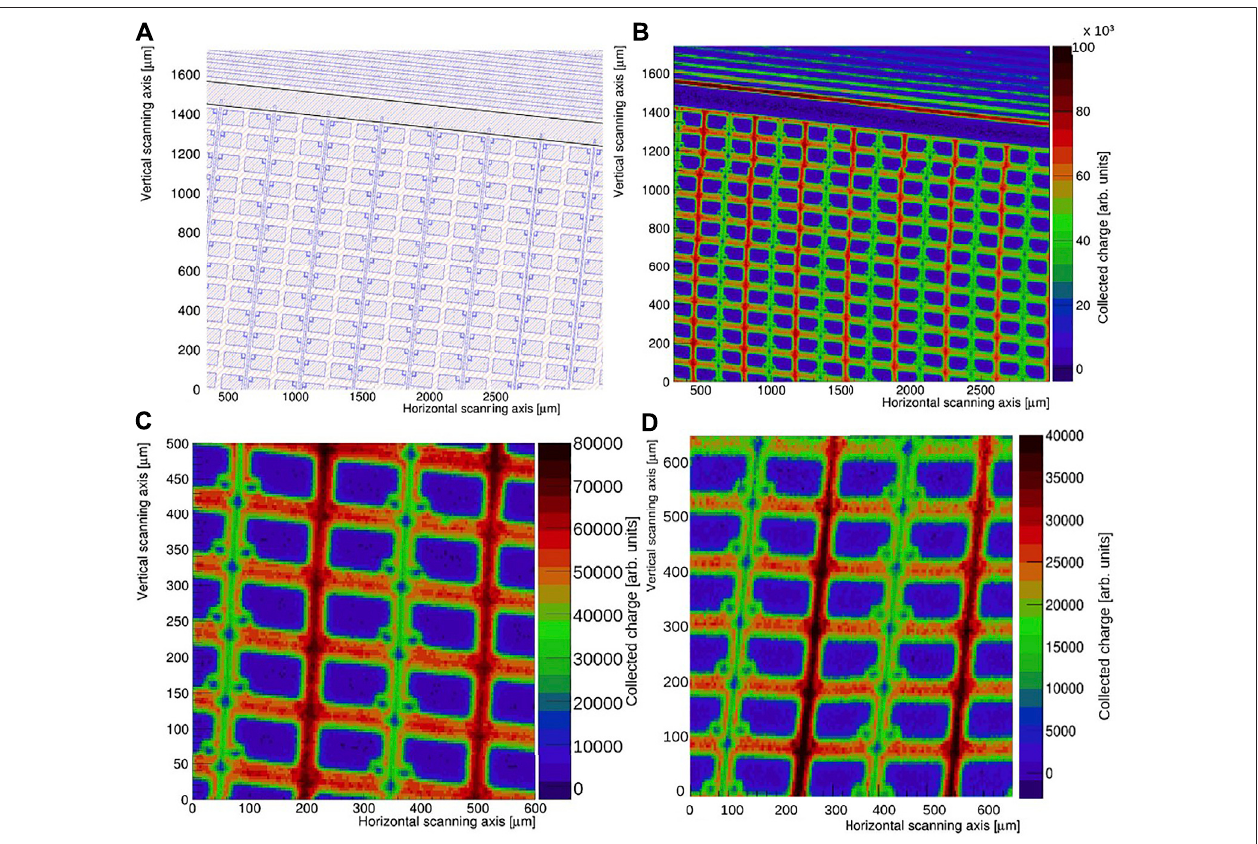
FIGURE 10 | Validation showing (A) the mask layout of an area of 2,700 × 1700 μ m 2 of a non-irradiated AC-coupled sensor with metallic bias line and (B) its correspondingchargecollection spatialhomogeneityscan.Spatialhomogeneityscansperformedatabiasof300 Vwithfrontillumination ofIRlasershowingascanned area of (C) 500 × 600 μ m 2 for 10 14 protons/cm 2 and (D) 620 × 650 μ m 2 for 10 15 protons/cm 2 irradiated AC-coupled pixel sensors with Al 2 O 3 + HfO 2 used as the dielectric